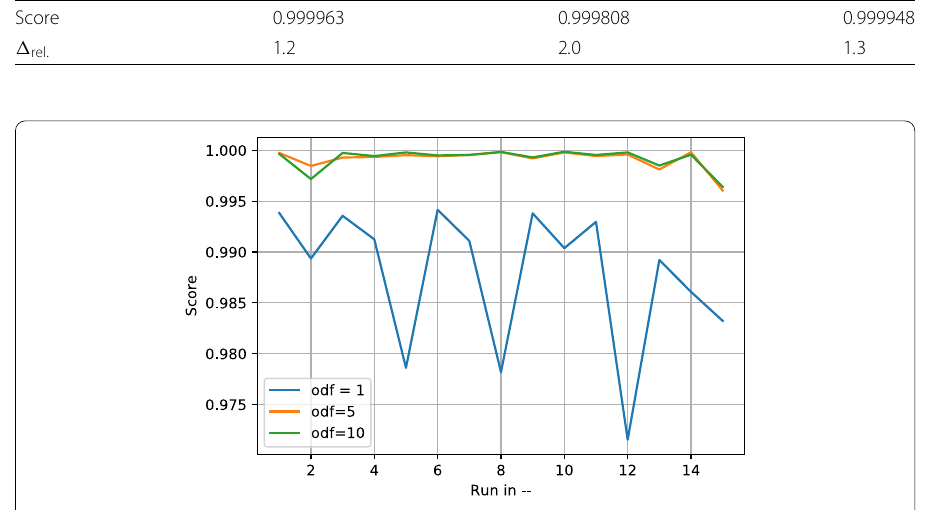
Fig. 31 Scores vs. fitting-run for several NN-fitting runs for different values of odf